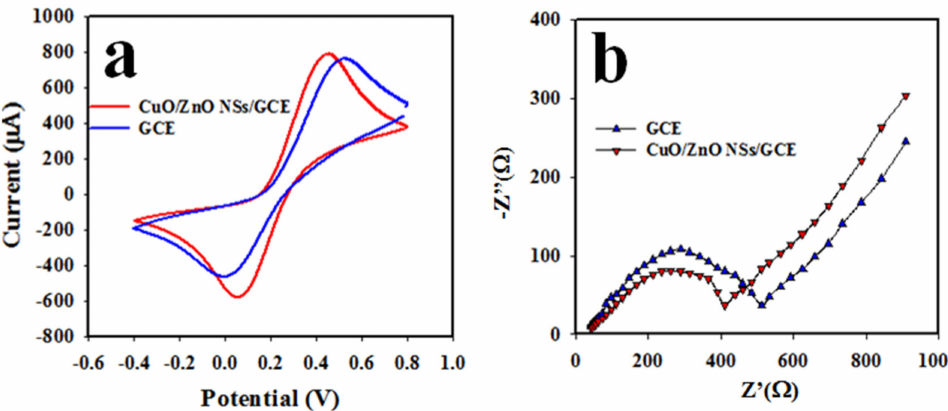
Figure 5. Electrochemical analysis of Nafion/CuO/ZnO NSs/GCE sensor probe. ( a ) The cyclic voltammetry of bare and CuO/ZnO NS-modified GCE in 0.1 mM ferricyanide/ferrocyanide [K 3 Fe(CN) 6 ] in a pH 7.0 buffer and ( b ) the electrochemical impedance spectroscopy (EIS) of bare and CuO/ZnO NS-modified Nafion/GCE in 0.1 mM ferricyanide/ferrocyanide [K 3 Fe(CN) 6 ] in a pH 7.0